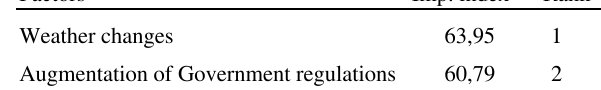
Table 10. Ranking factors under external group